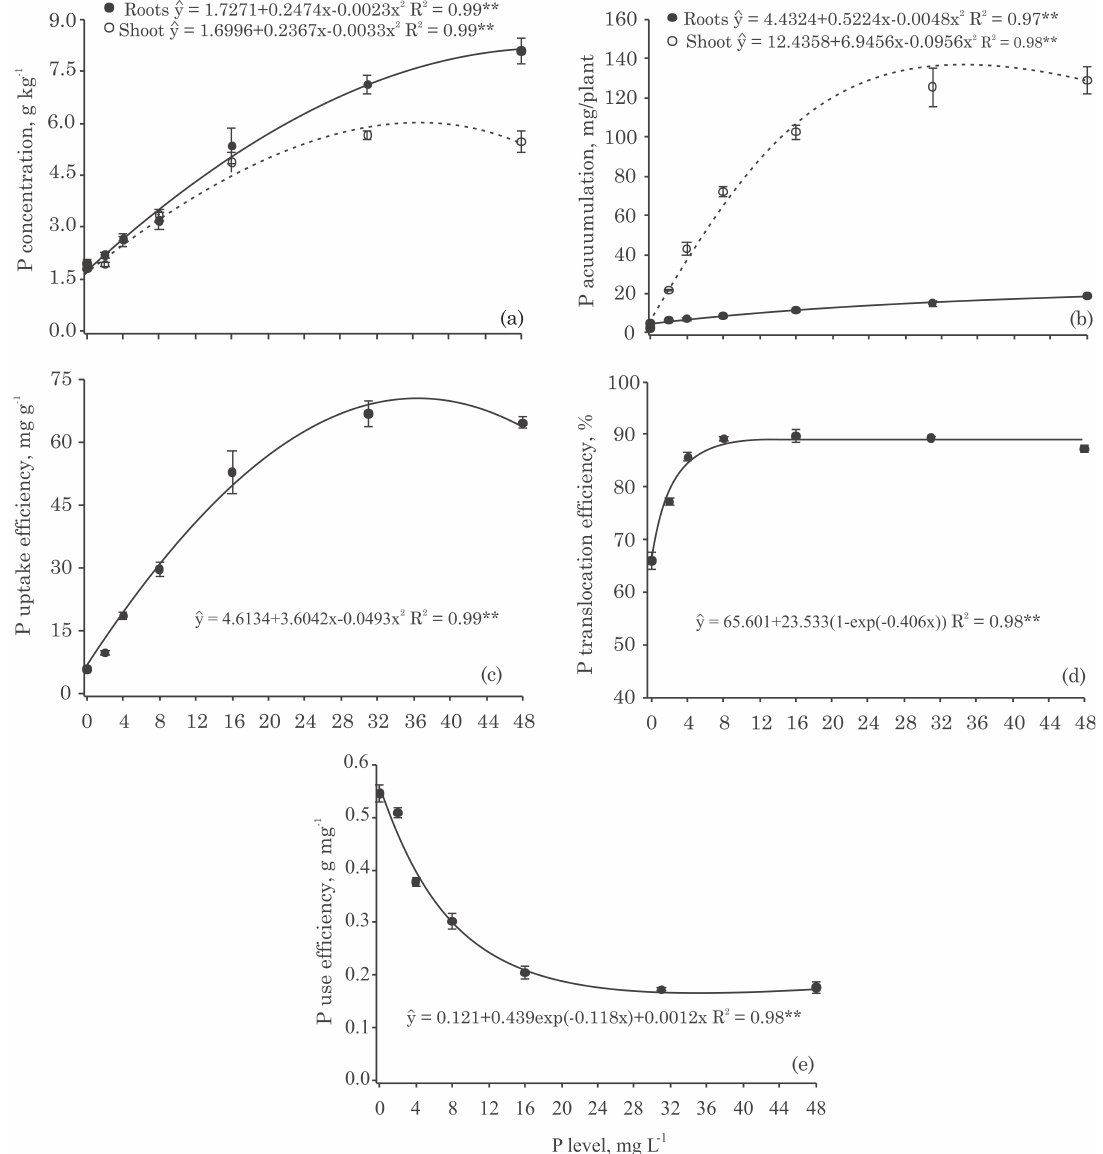
Figure 2. Phosphorus concentration (a) and accumulation (b) in roots and shoot, uptake efficiency (c), translocation efficiency (d) and use efficiency (e) in potato plants, cv. Ágata, as affected by P levels in the nutrient solution. * p > 0.05 and ** p > 0.01. Vertical bars represent the standard